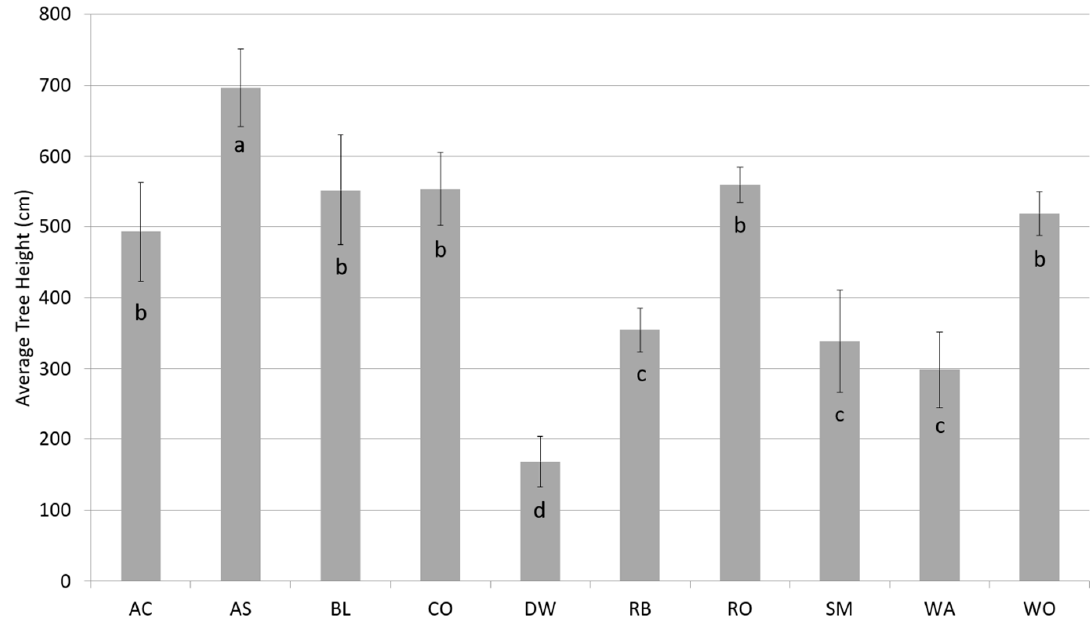
Figure 4. Average tree height (cm) for each species across brown sandstone plots only. Error bars represent ± SE. Means with different letters are significantly different ( p < 0.05). AC = American chestnut, AS = American sycamore, BL = black locust, CO = chestnut oak, DW = dogwood, RB = redbud, RO = northern red oak, SM = sugar maple, WA = white ash, WO = white oak.